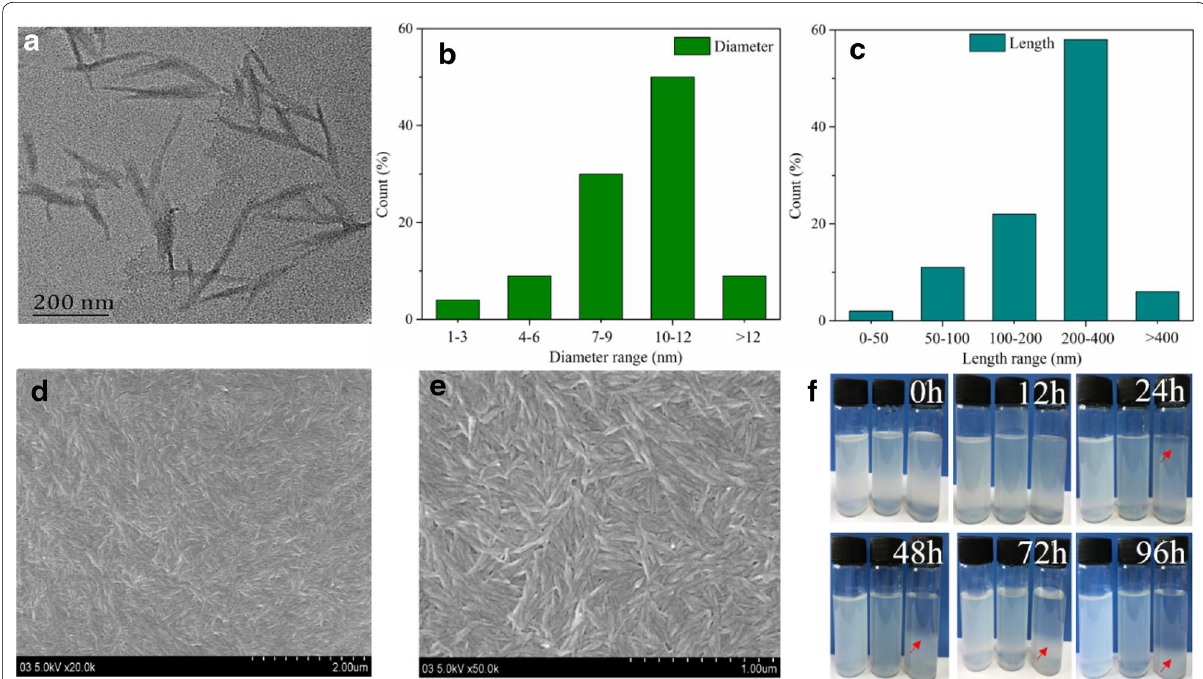
Fig. 4 a TEM micrograph of the obtained CNC; b , c diameter and length distribution of the obtained CNC; d , e SEM micrographs of the obtained CNC; f stability of the CNC dispersed in water, ethanol and acetone (from left to right in each picture)